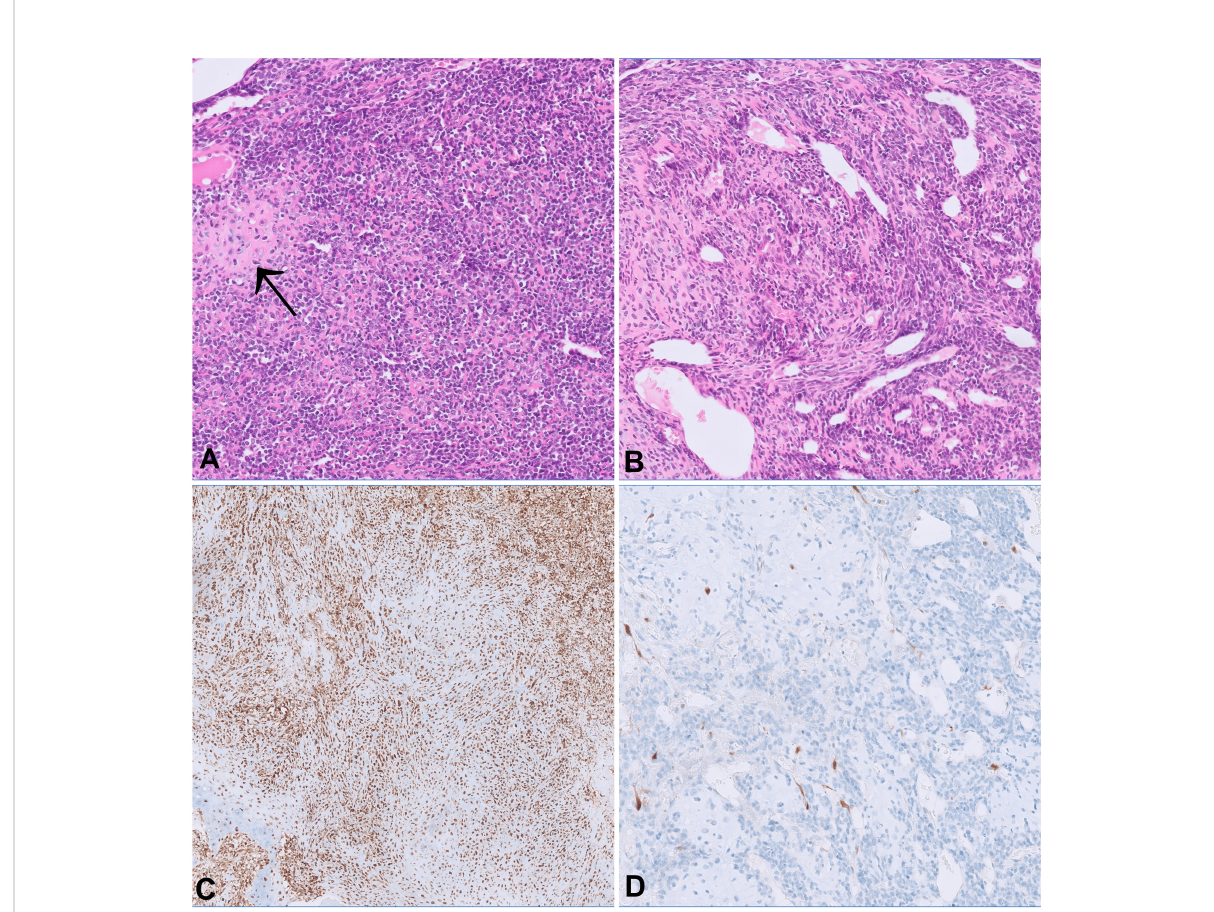
FIGURE 1 The morphology of both the primary tumor (A) and the metastasis from the femoral head (B) show cellular sheets of small round to spindle cells merging with foci of cartilaginous differentiation (arrow). On immunohistochemistry, p16 expression is retained in the primary tumor (C) and lost in the metastasis (D)